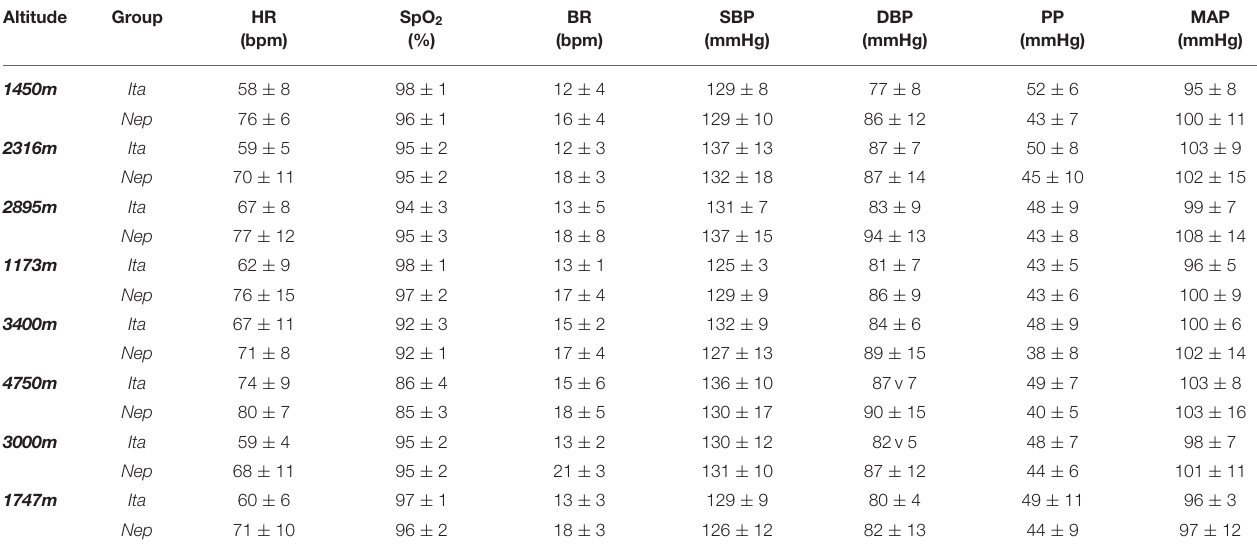
TABLE 1 | Cardiorespiratory results, clustered by altitude, and ethnic group. Altitude Group